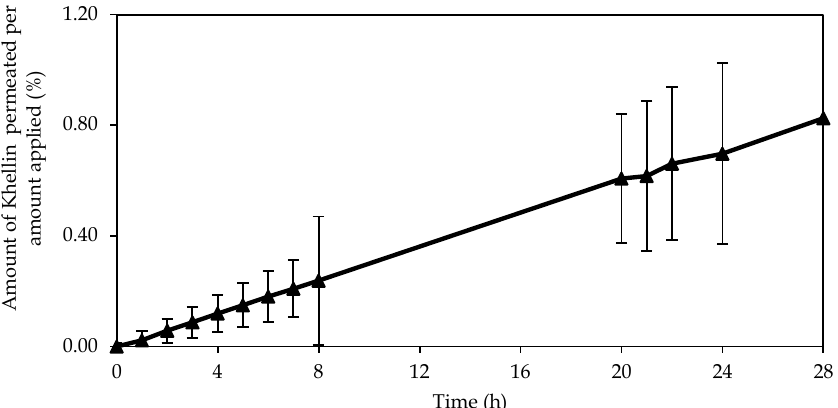
Figure 6. Permeation profile of KHE from gel-in-oil emulsion A through human stratum corneum (mean ± SD, n = 9).